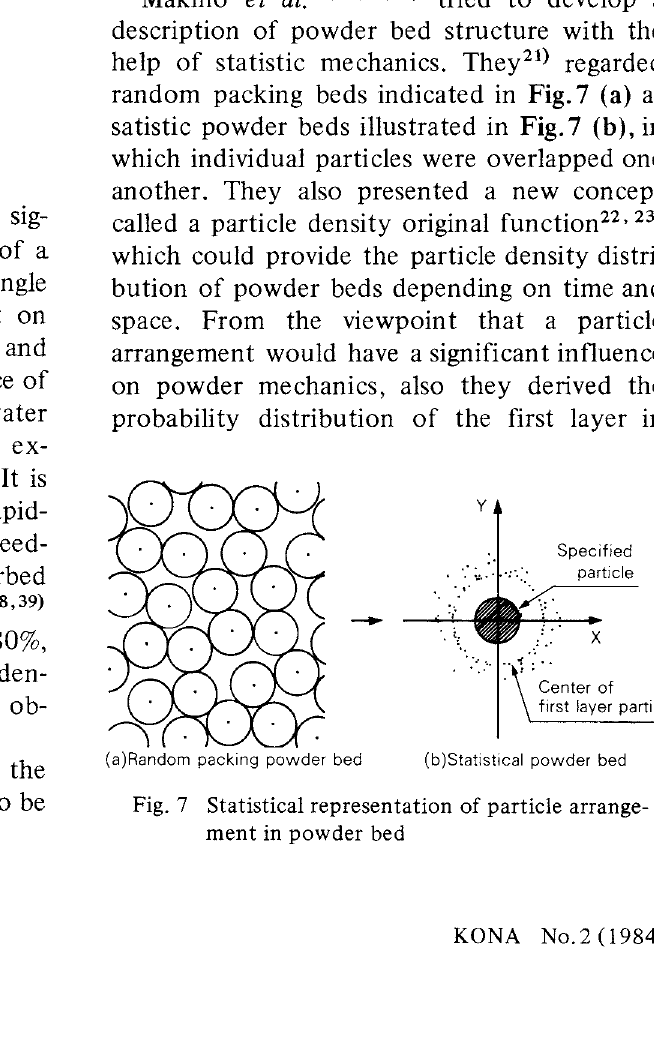
Fig. 6 Change in adhesive force of glass bead(GB503M) at a contact point